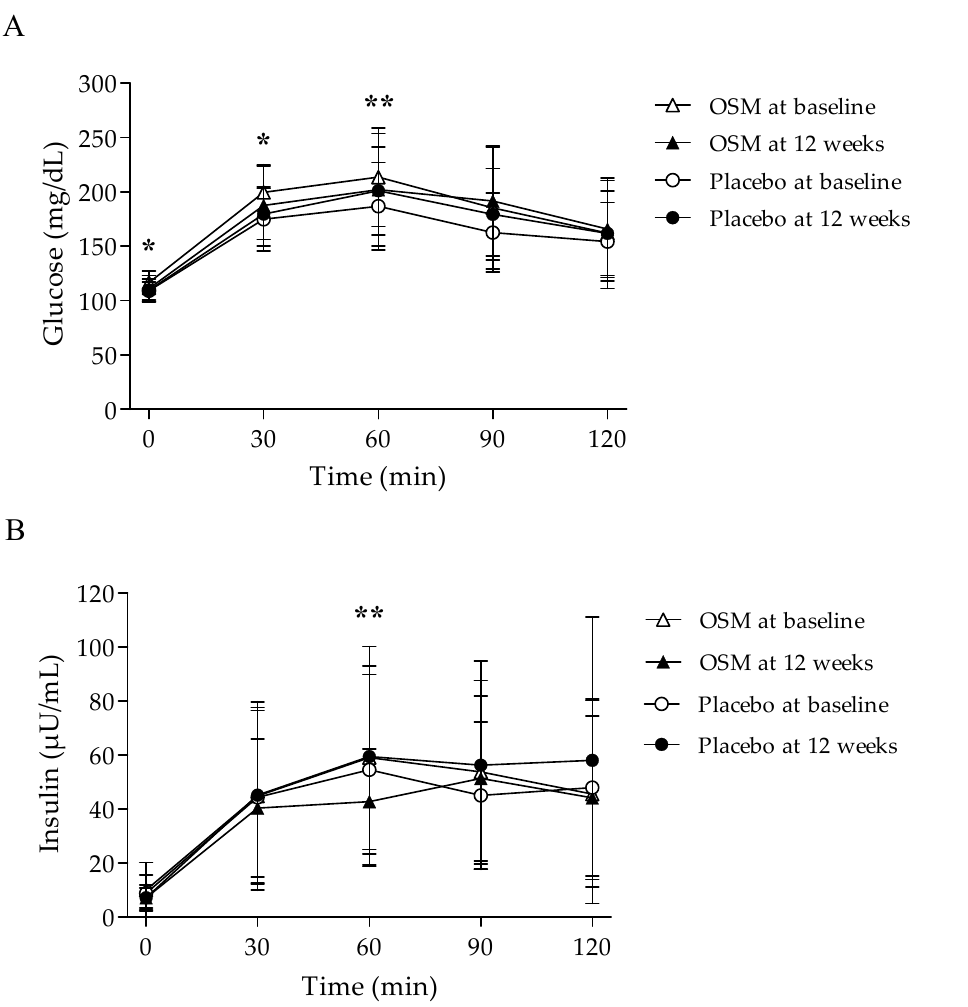
Figure 2. Effects of OSM on plasma glucose and insulin levels during the oral glucose tolerance test (OGTT) after taking the supplement for 12 weeks. ( A ) Plasma glucose level; ( B ) Plasma insulin level. Subjects in the OSM group were administered OSM at 500 mg/day for 12 weeks. Data are expressed as means ± SD. Between-group differences were assessed using ANCOVA (adjusted on the baseline of FPG, HbA1c). * p < 0.05, ** p < 0.01 vs. placebo group.